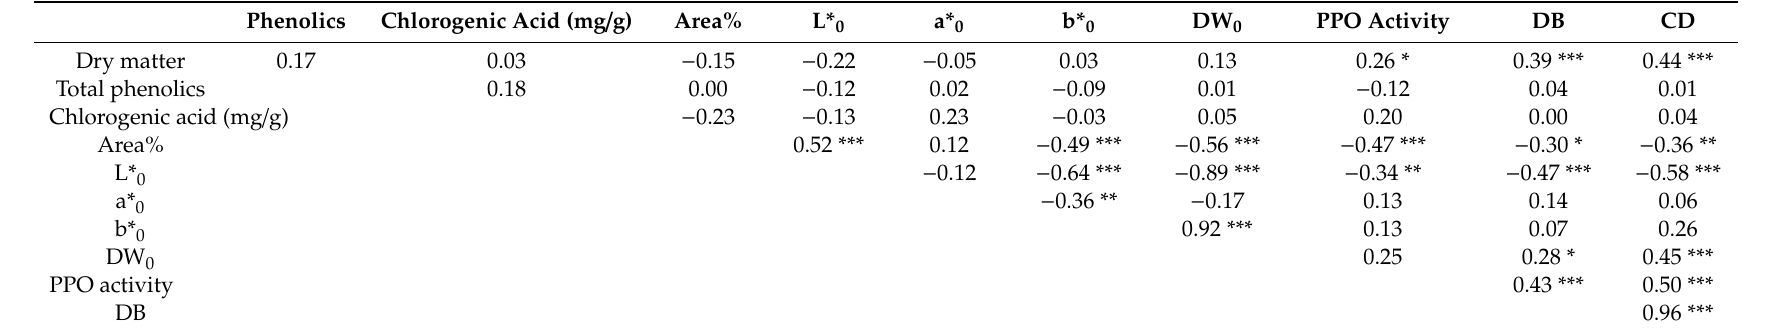
Table 5. Pearson linear correlations for all 13 biochemical traits